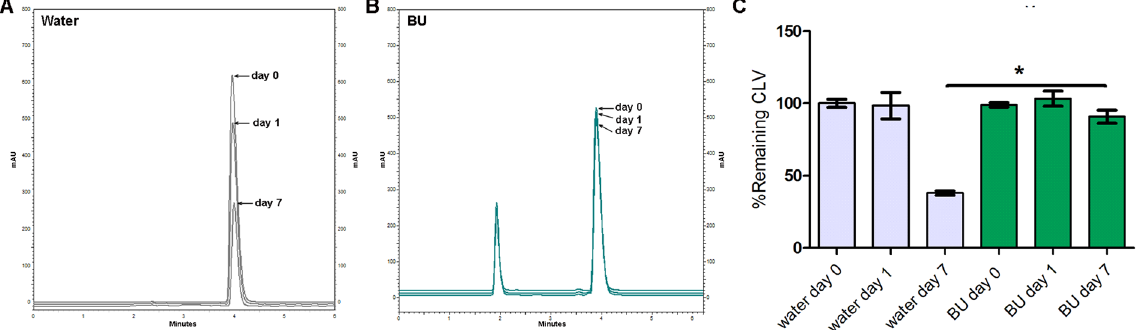
Figure 6. Representative chromatograms obtained of clavulanic acid (CLV) dissolved in water ( A ) and in BU ( B ) of samples of 11 mg/ml after 0, 1 and 7 days. ( C ) Shows chromatogram quantification. Results are expressed as median ± SEM of three experimental replicates.